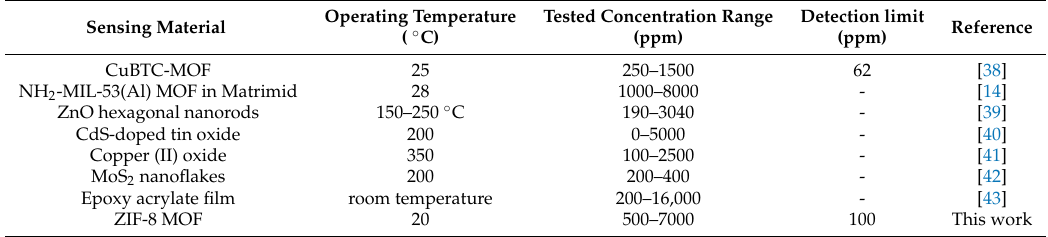
Figure 7. ( a ) Sensing response for methanol concentration from 500 ppm to 7000 ppm. ( b ) Langmuir isotherm fit. ( c ) Response to 5000 ppm of methanol. ( d ) Comparison between methanol, ethanol, and water vapor normalized with the dielectric constant. Table 3. Comparison of the developed ZIF-8 MOF methanol sensor and a variety of methanol sensors in